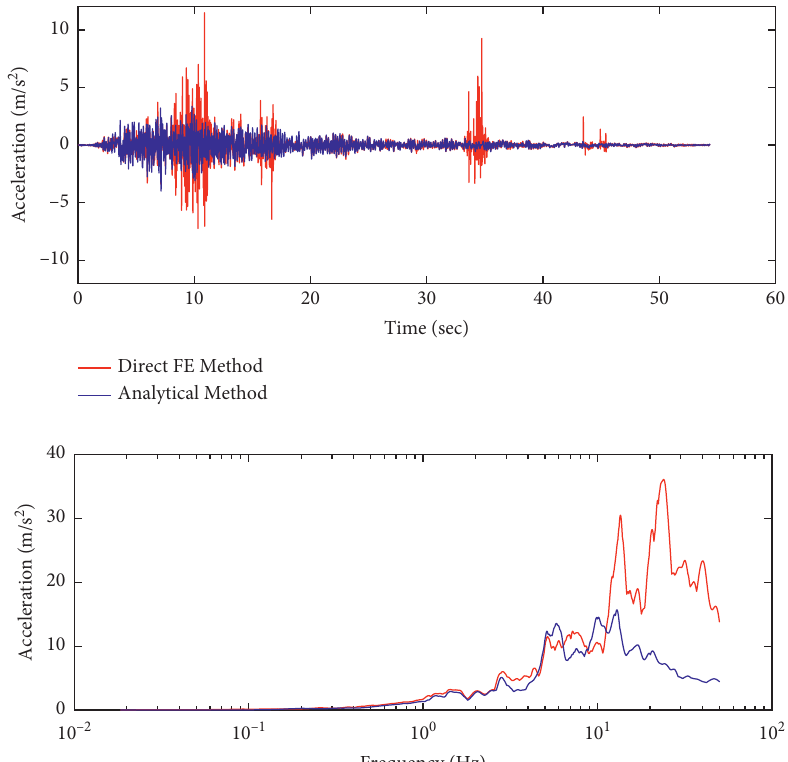
Figure 17: Acceleration time history and corresponding response spectrum induced by the Taft earthquake for a middle point at the dam crest in the cross-stream